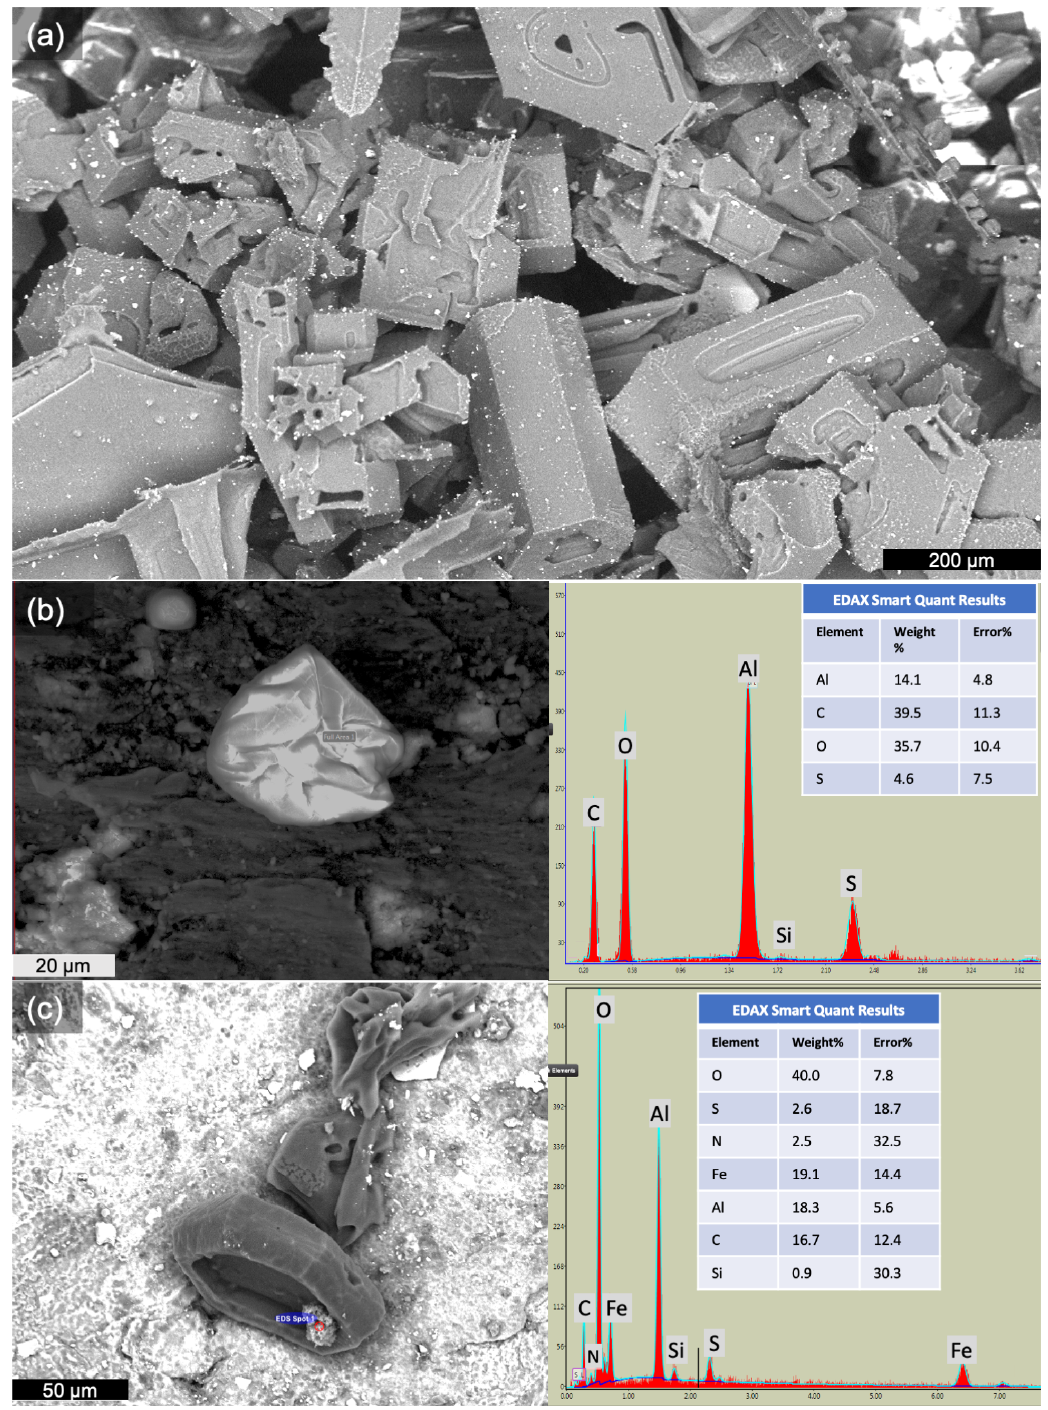
Figure 4. Three-panel particle images and energy-dispersive X-ray spectroscopy (EDAX Octane) statistics on ice particle contaminants. (a) Image of high-aerosol loading on 13 June 2018 at 100 × magnification (Supplement file 1D for additional details). (b) Fly ash particle (not ice) captured outside cirrus cloud, with EDS composition. (c) Shallow hollowed trigonal ice particle with iron-rich embedded aerosol (25 June 2019).